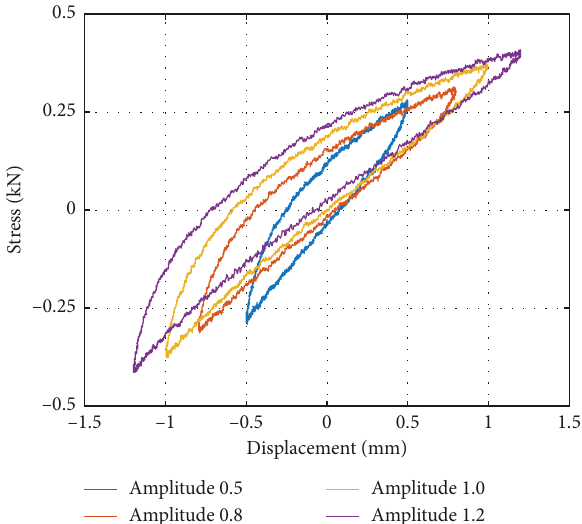
Figure 13: Hysteresis loops of MR under different amplitude conditions.